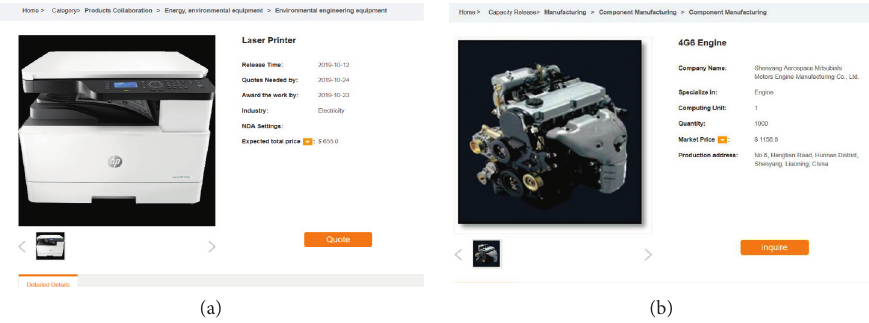
Figure 1: The cases of two trading strategies: (a) demand-driven case and (b) capacity-driven